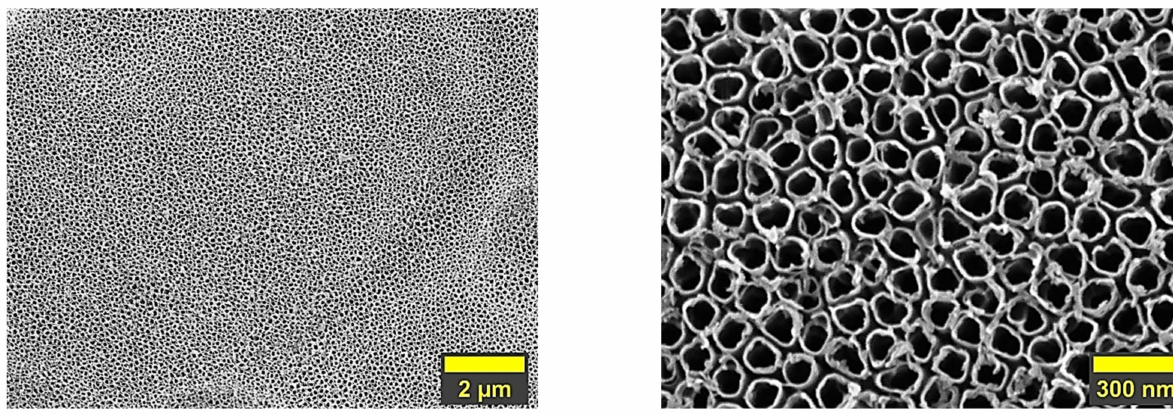
Figure 1. SEM images of the nanostructured surface after annealing (see Figure S1 in Supplementary File for the original SEM